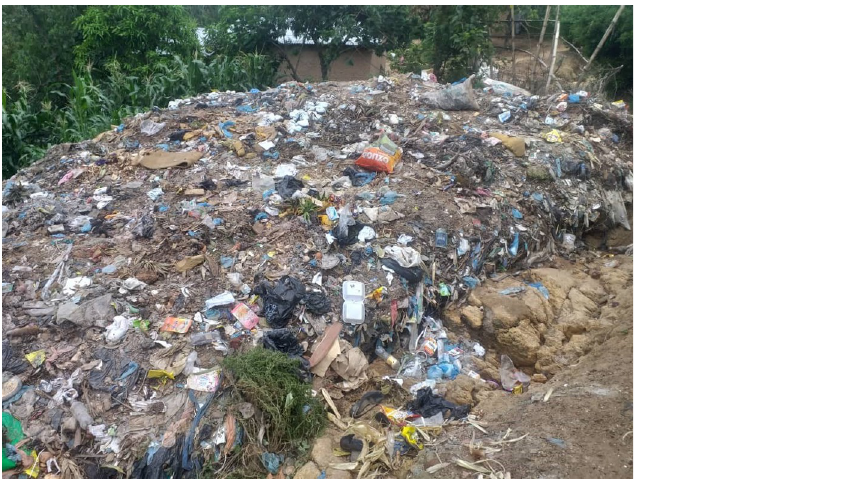
Fig 1. One of the numerous dumping grounds in